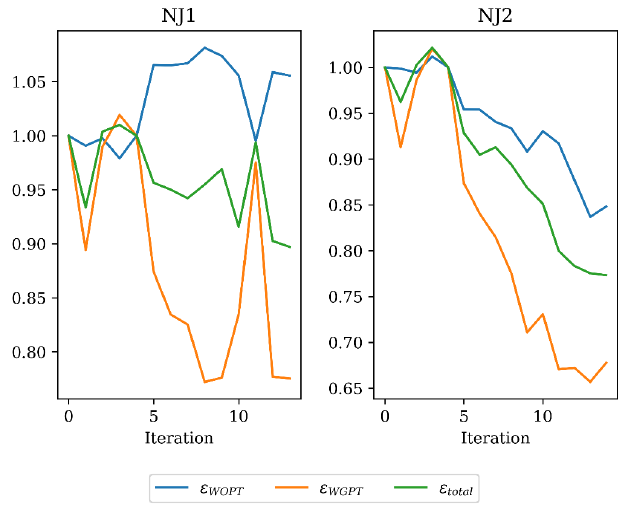
Figure 16. The convergence history for the automatic history matching of the wells from the North Jens area, obtained with the Nelder–Mead optimization algorithm. The curves are normalized with regard to their values at the start of iterations.